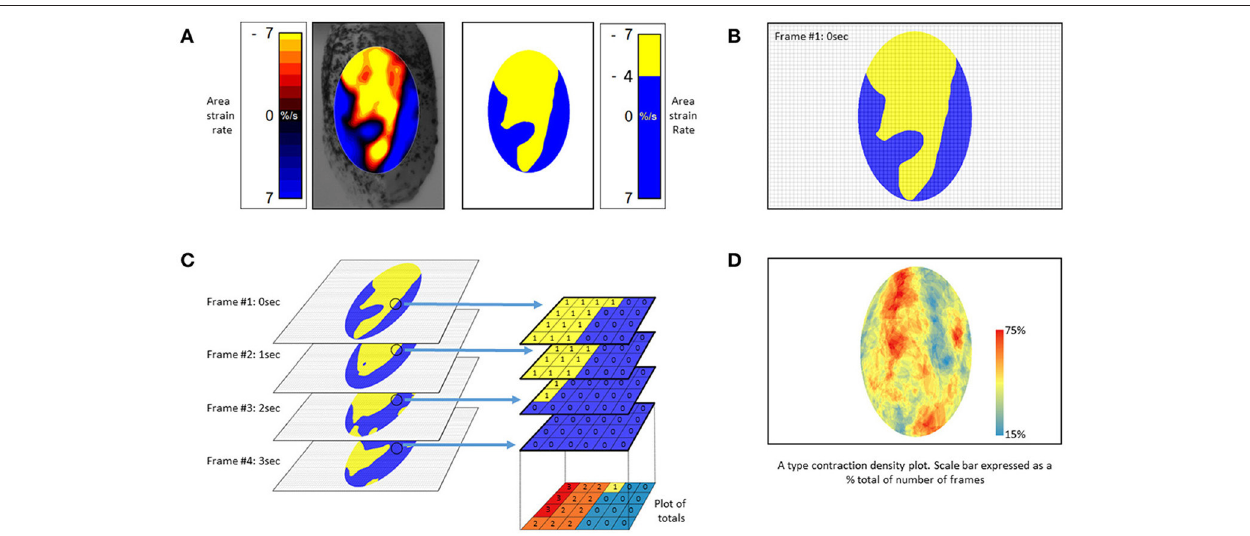
FIGURE 10 | Method of construction of (A) type contraction density plots. (A) Successive Area Spatiotemporal maps are thresholded to include all sites at which strain rate exceeds a chosen value (in this case < -4% strain s − 1 ). (B) Frames are suitably subsampled at chosen time intervals; (C) The subsampled frames, taken over a chosen time span, are stacked and the number of frames within each pixel of the stack with strain rates in excess of the chosen threshold counted. The results are then plotted as a color coded percentage total to produce a stacked A-type contraction density plot. (D) Typical stacked (A) type contraction density plot covering over 45% of the anterior surface of the bladder. (B) Adapted from Hulls et al.